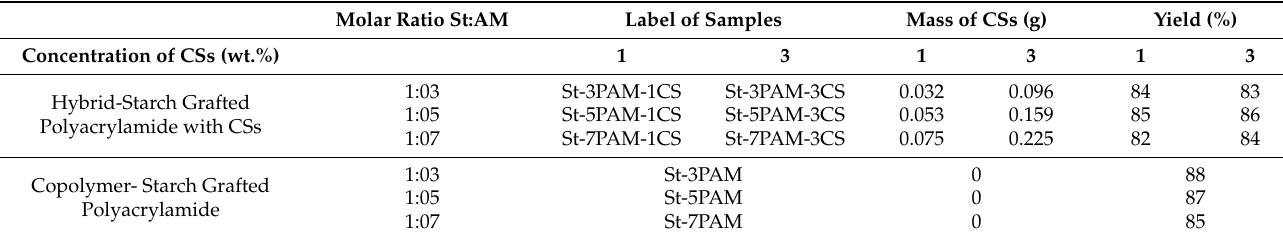
Table 1. Detail of hybrids and starch grafted copolymer synthesis.